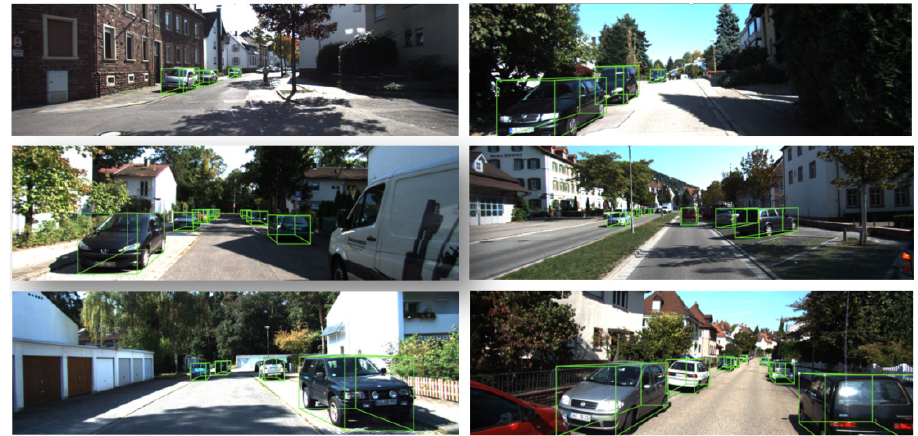
Figure 8. Qualitative experimental results of our method.